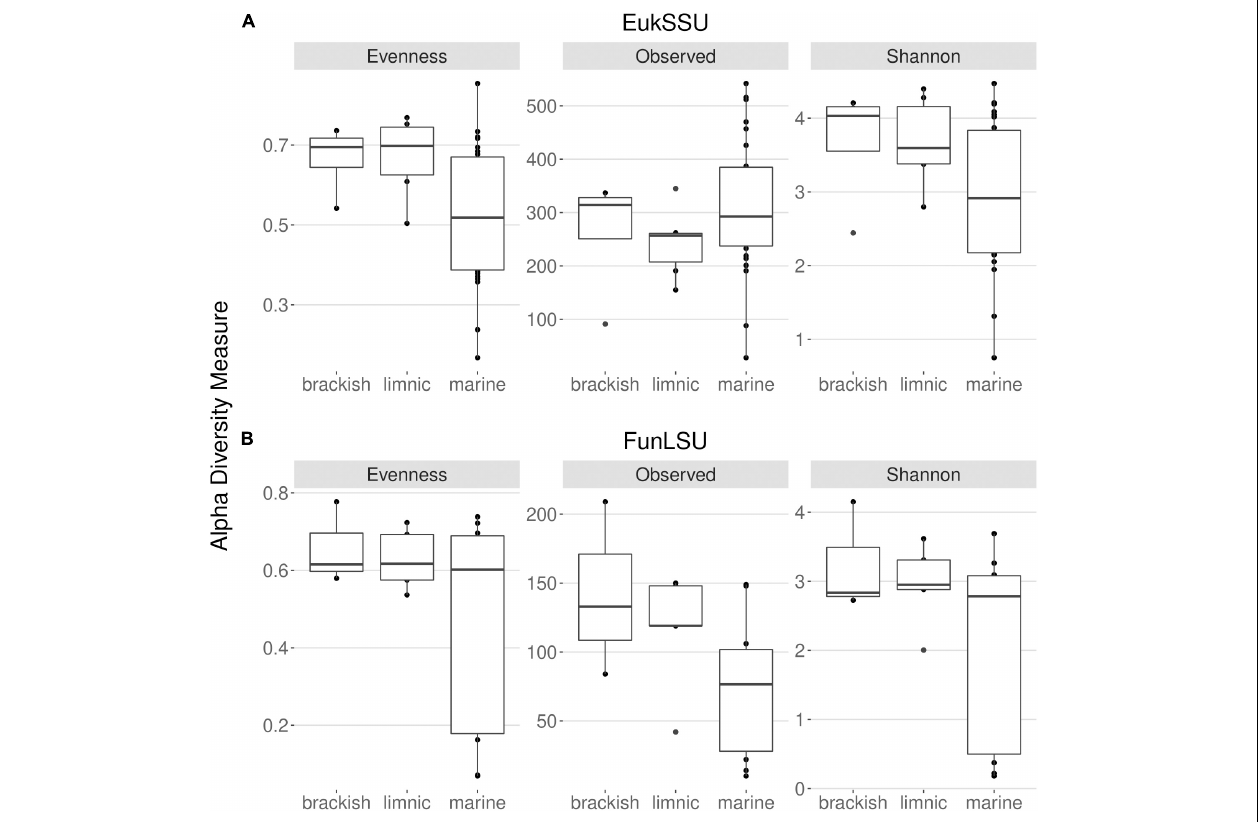
FIGURE 2 | Distribution of the alpha diversity estimators according to sampled water types in (A) 18S and (B) LSU data. This includes Pielou’s evenness, observed ASV richness and Shannon diversity index.